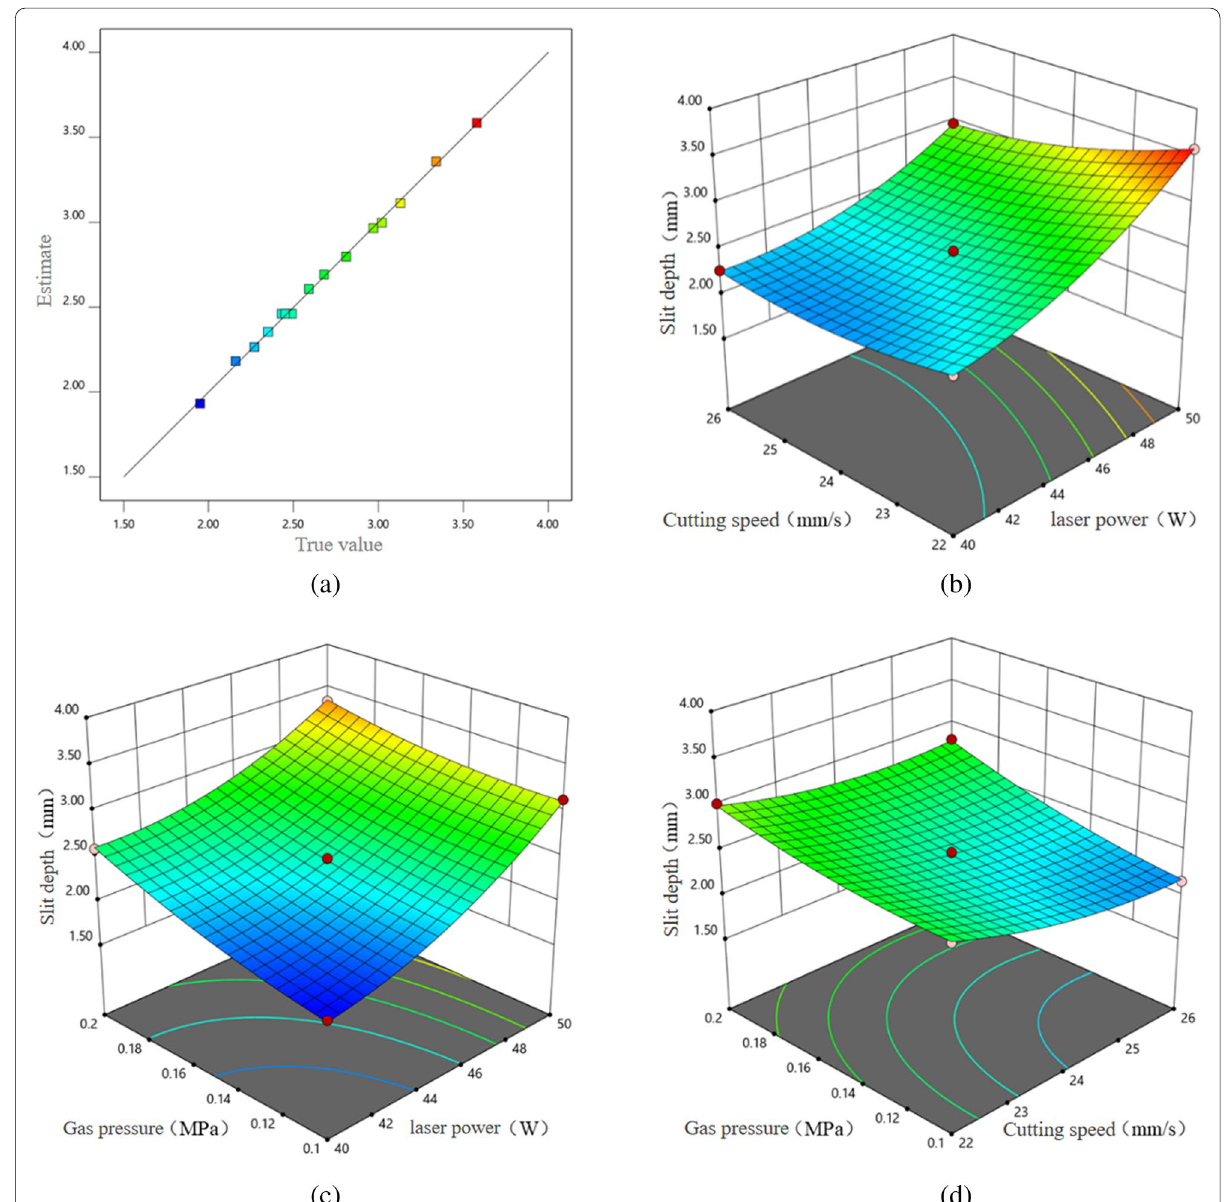
Fig. 11 Response surface diagram of cutting depth of inert gas-assisted laser cutting wood. a Comparison between predicted and actual. b Interaction of laser power and cutting speed. c Interaction of laser power and gas pressure. d Interaction of cutting speed and gas